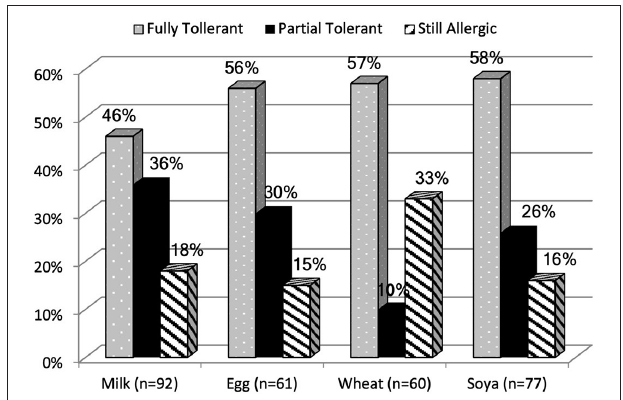
FIGURE 1 | Outcome of HIP of allergens categorized as fully tolerant, partially tolerant and still